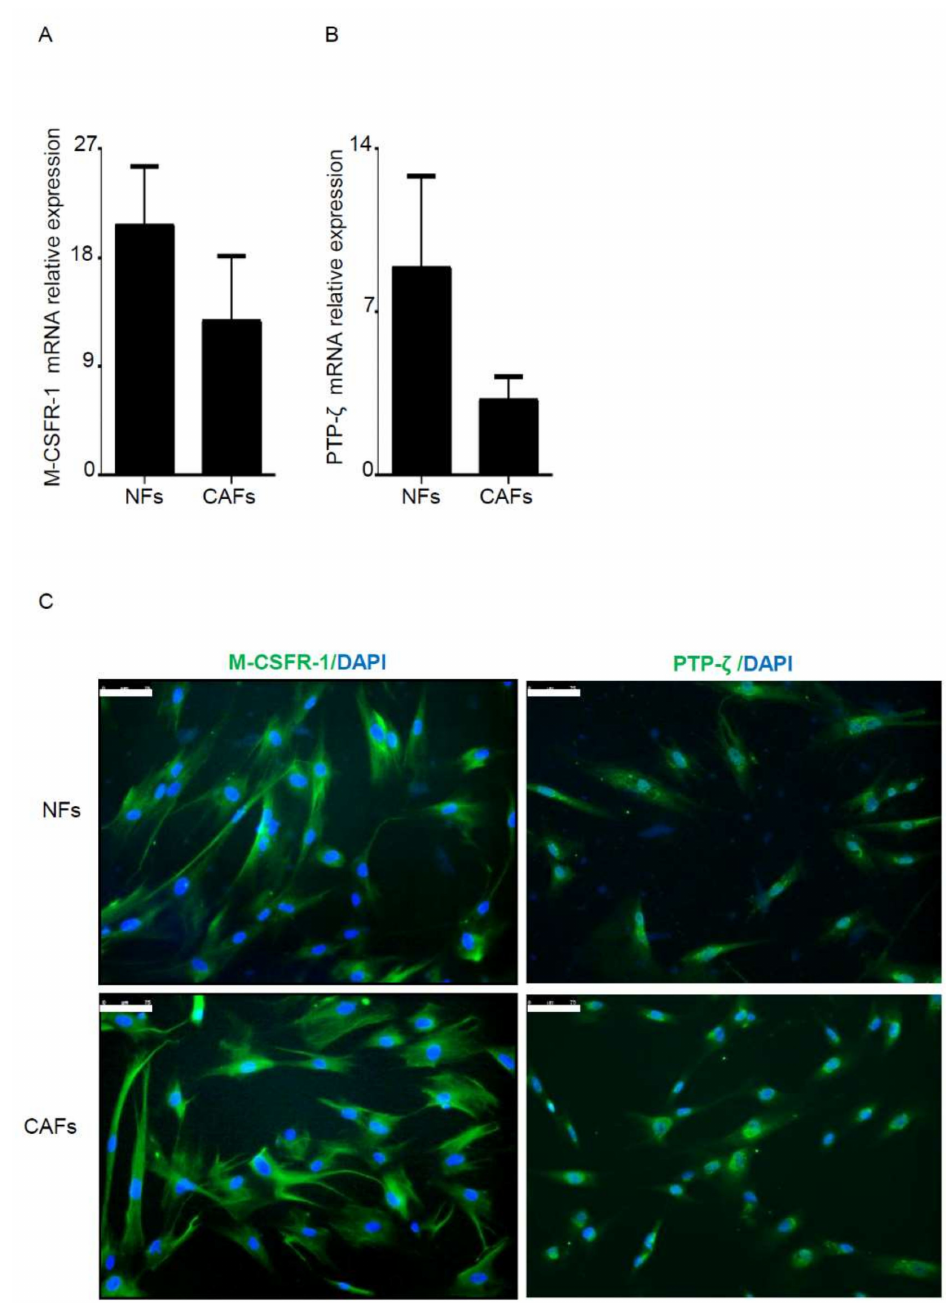
Figure 2. Both normal fibroblasts (NFs) and cancer-associated fibroblasts (CAFs) express IL-34 receptors. A – B : NFs and CAFs were evaluated for the expression of macrophage colony-stimulating factor receptor (M-CSFR-1) ( A ) and PTP- ζ ( B ) RNA transcripts by real-time PCR; levels were normalized to β -Actin and data were expressed as mean ± SEM of six patients. ( C ) Representative images of immunofluorescence staining of NFs and CAFs taken from tumoral and non-tumoral area, respectively, of one patient with colon cancer and analyzed for the expression of M-CSFR-1 (green), PTP- ζ (green), and DAPI (blue). The example is representative of three separate experiments in which cells of three patients with colon cancer were analyzed. The scale bars are 75 µ